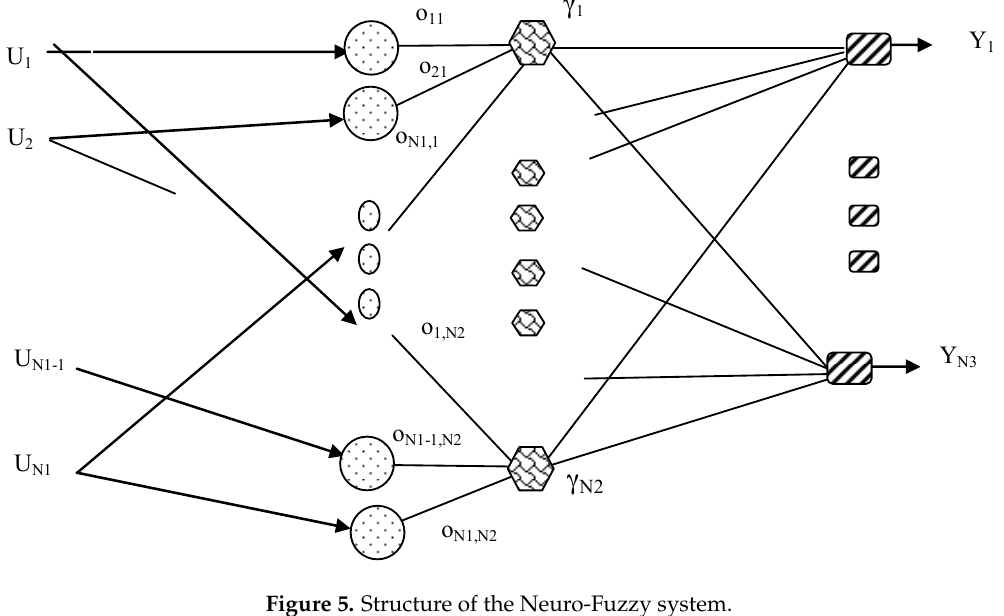
Figure 5. Structure of the Neuro-Fuzzy system.